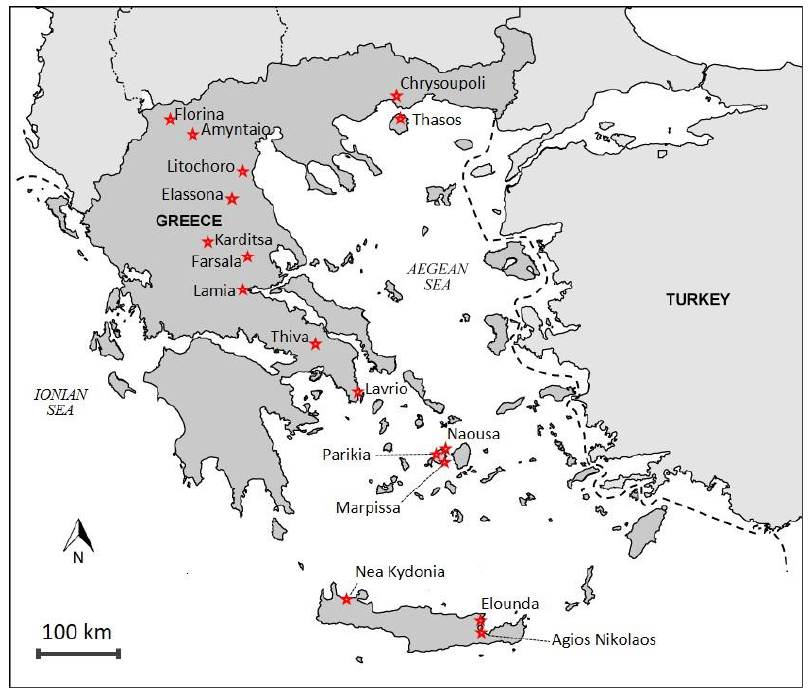
Figure 2. Locations of the WWTPs that participated in the study.